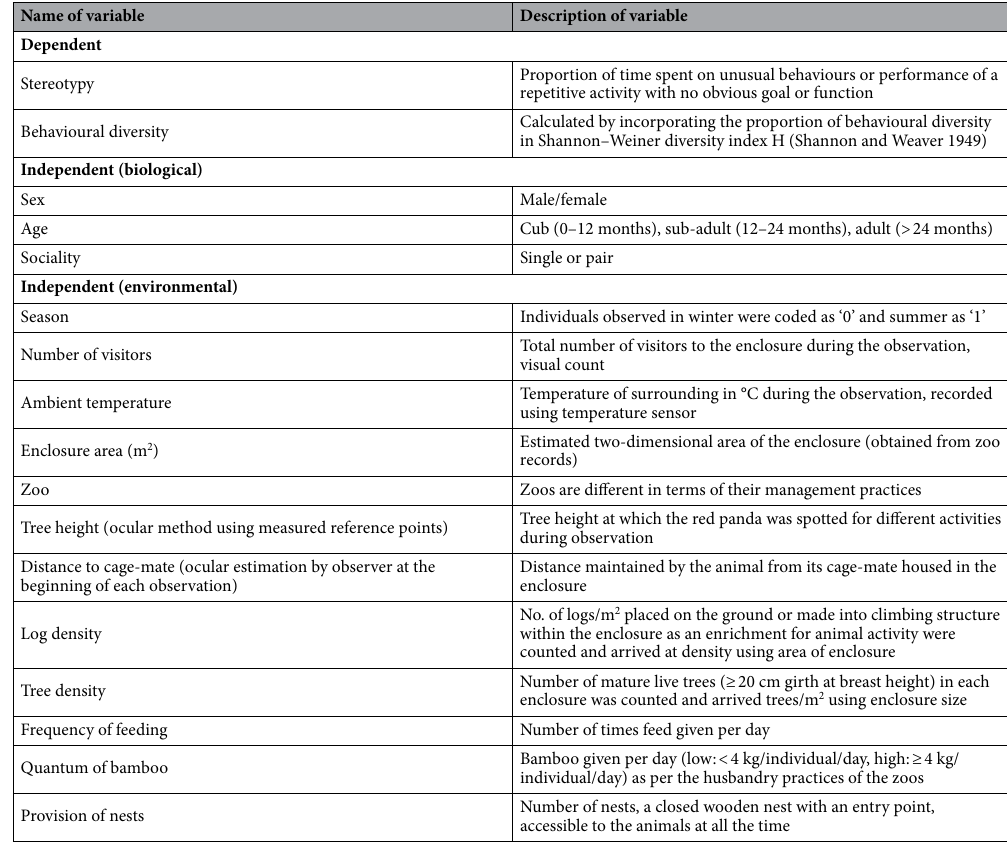
Table 5. List of dependent and independent (environmental and biological)